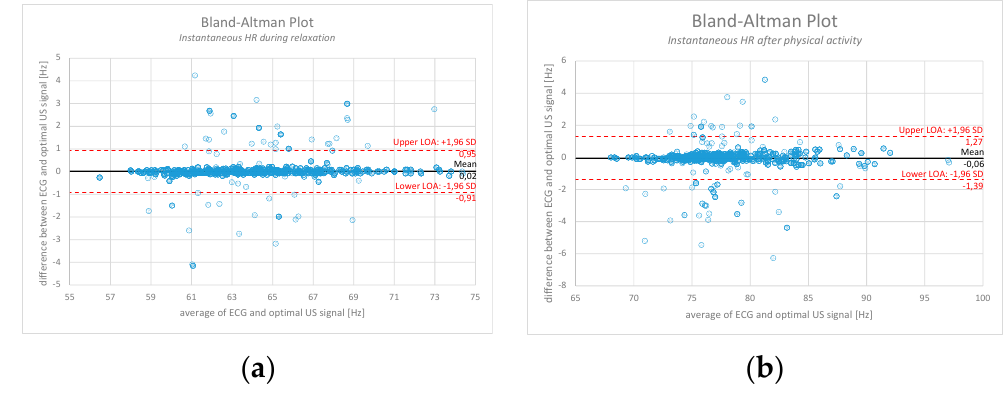
Figure 13. Bland-Altman plot comparison between the calculated instantaneous HR obtained from the ground truth ECG and the optimal US signal (where known unwanted artefacts have already been filtered out). ( a ) represents an example measurement during relaxation period (95.6% of the signal lies within the LOA); ( b ) represents an example measurement after physical activity (94.9% of the signal lies within the LOA). Table 8. HR statistical parameters for clinical experiment.